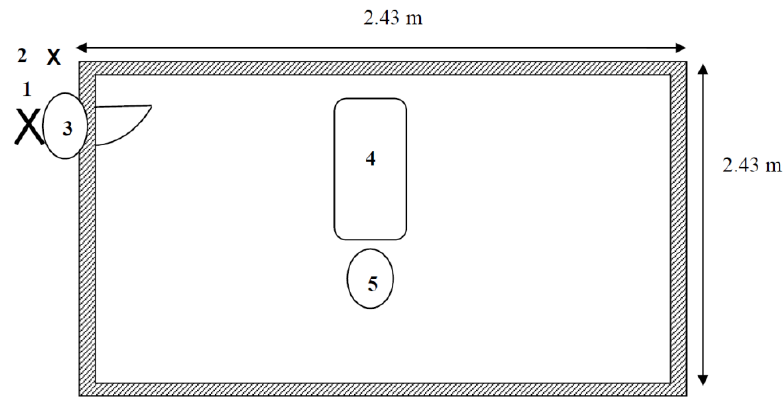
Figure 1. The experimental environment. 1 = Observer position, 2 = Site of the Pet